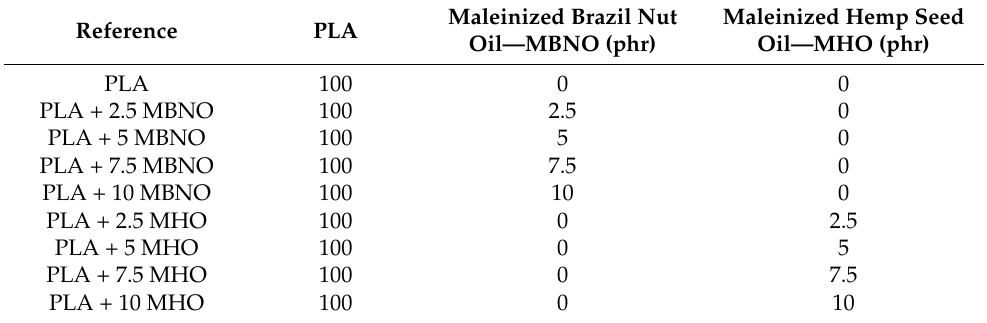
Table 1. Composition of plasticized PLA with different contents (phr) of maleinized vegetable oils and labeling of the